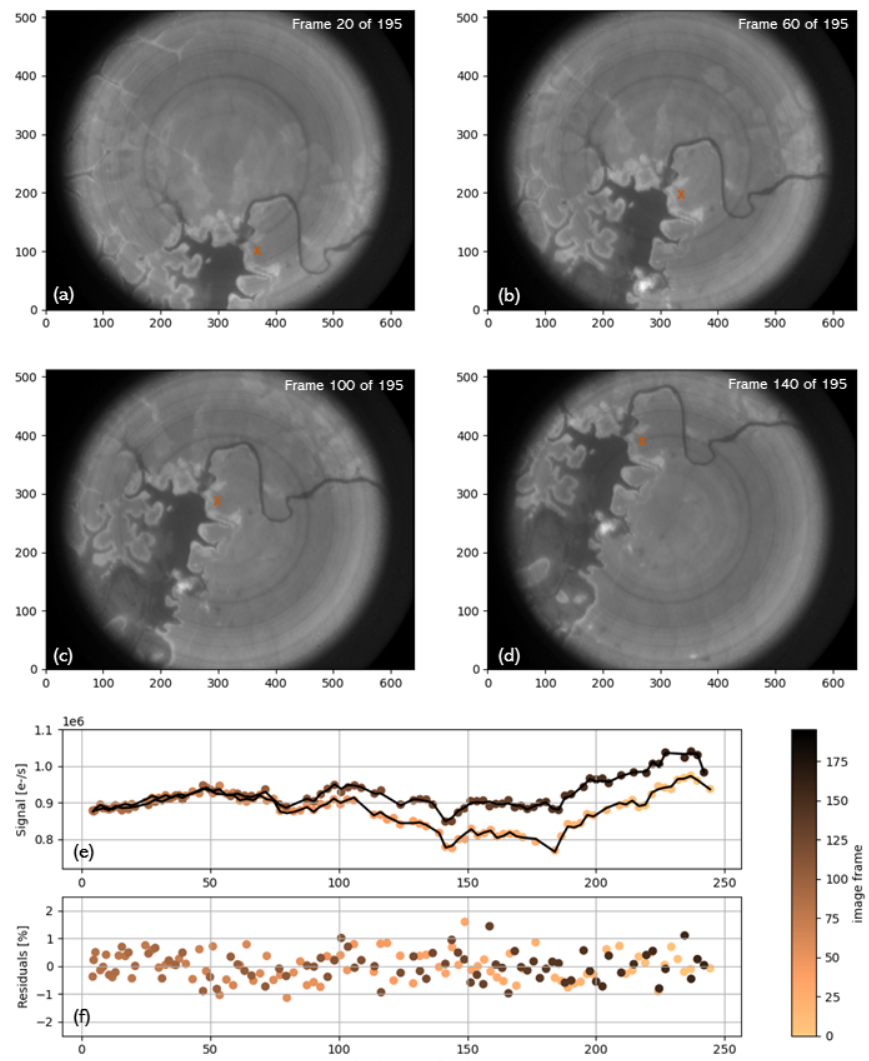
Figure 4. The panels (a, b, c, d) show a selection of frames from an observation over the Lom Pangar hydroelectric reservoir in Cameroon taken on 20 April 2017 with an example ground location (denoted by an orange “x”) tracked in each frame. The image axes are in pixels, with each pixel representing a 24 × 24m 2 area on the ground. The plot in (e) shows the signal (circles) from the example ground location as a function of the image frame (circle colour) and radius from spectral ring center (horizontal axis). The forward model (black line) is plotted alongside the signal data, and residuals between model and data are shown in (f)